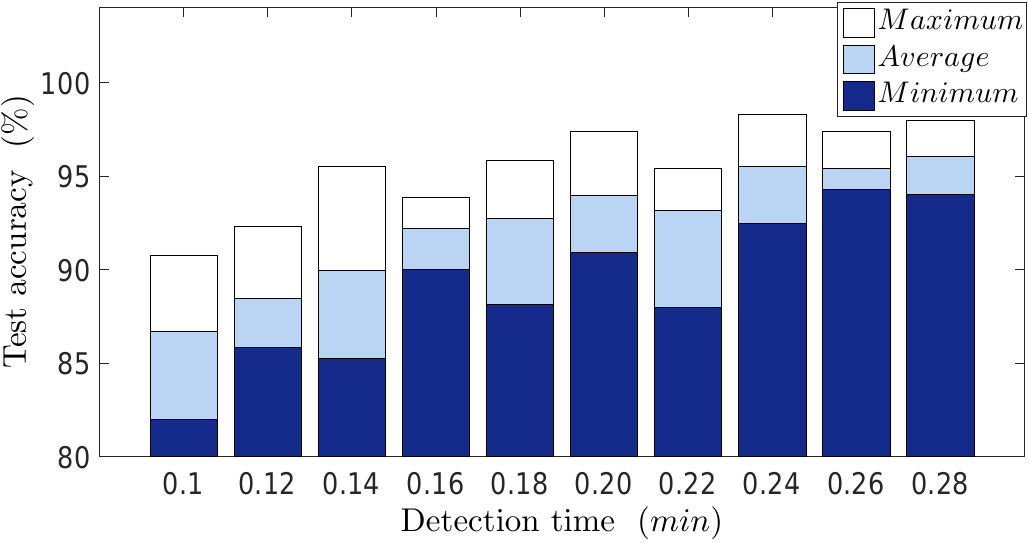
Figure 10. The test accuracy of neural network with respect to the size of training and test data. Table 3. Confusion matrix of the neural network.